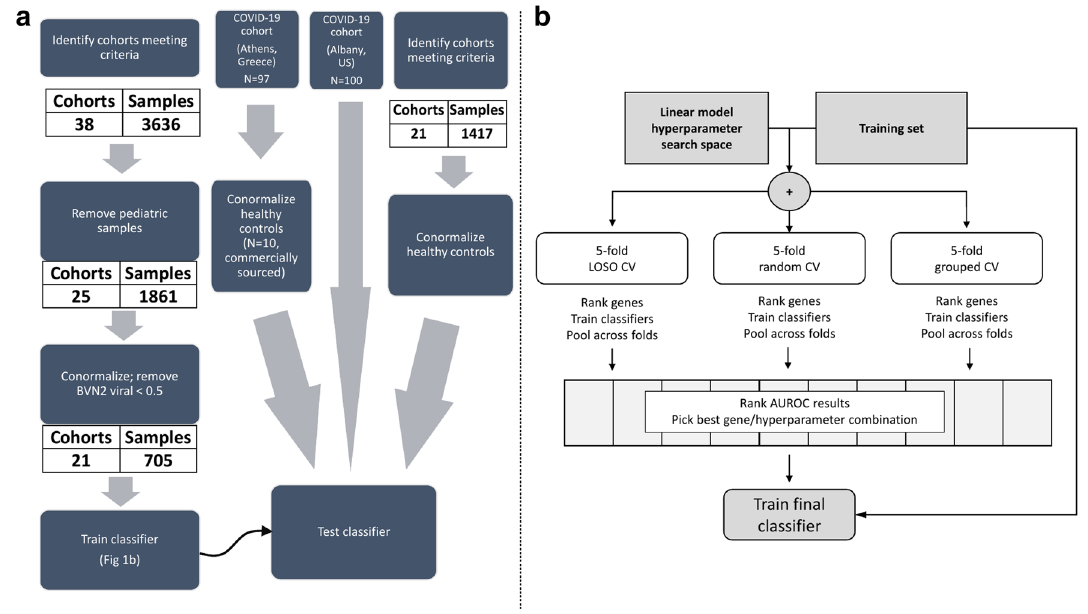
Figure 1. Study flow. ( a ) Clinical data flows for training and testing. ( b ) Machine learning worfklow used to develop and validate the 6-mRNA viral severity classifier. LOSO Leave-One-Study-Out, CV cross-validation, AUROC Area Under ROC